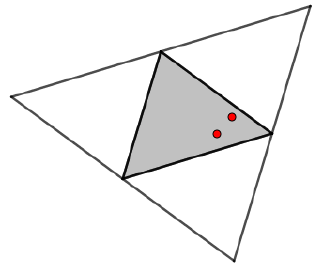
Figure 3. Change from disjoint to equal after gridding of point features.